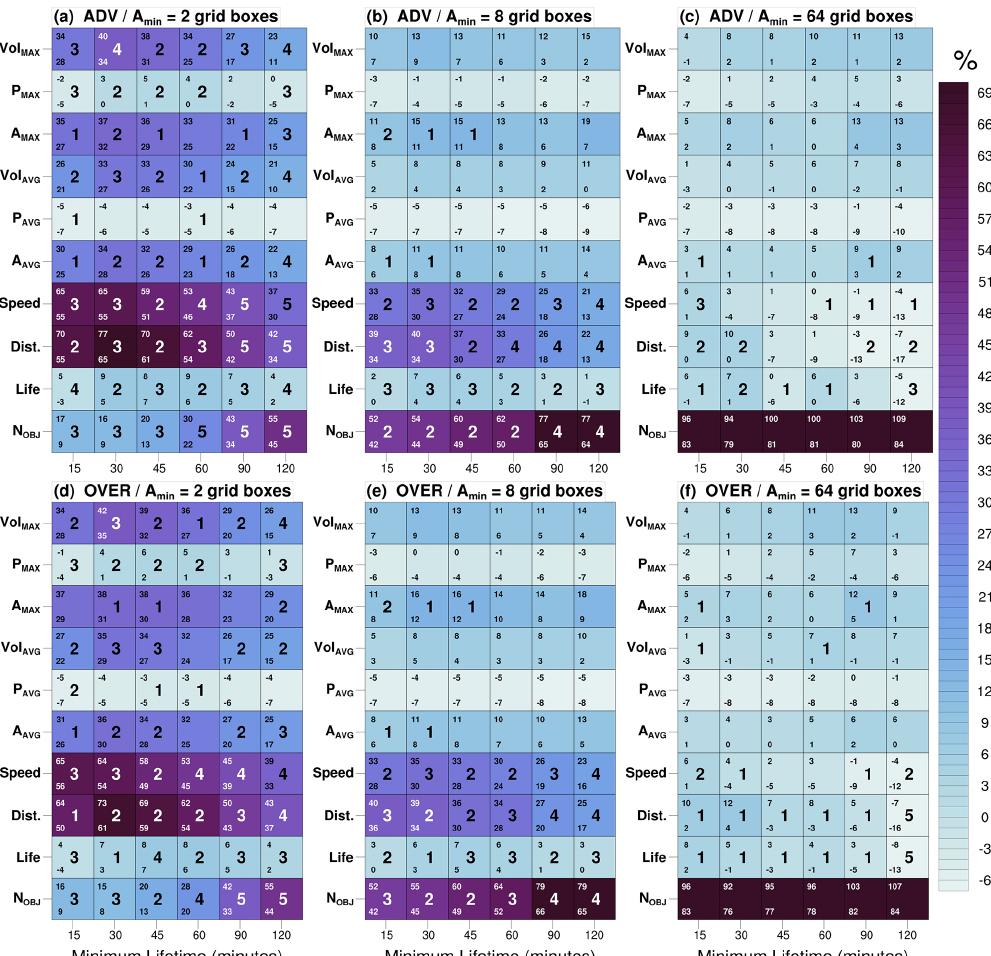
Figure 6. Climate-change signals of all object properties and N obj , as a function of the object’s minimum-lifetime ( T min ) criterion, for both algorithms. A statistically significant difference in the climate-change signal against other T min thresholds is indicated by a number in the box centre. The number denotes how many of the other T min thresholds have a change signal whose difference is statistically significant compared to the box in question (maximum = 5). For example, for the combination (d) OVER, A min = 2, speed and T min = 15min, the number 3 is present: this means that the climate-change signal for this combination has a statistically significant difference to three of the remaining five T min thresholds of OVER, A min = 2 and speed. Confidence intervals, computed as in Sect. 3.4, are given in the left-hand corners of each box. There are no statistically significant differences between the algorithms. The results are shown for three values of A min , with the remaining values of A min found in Fig. S5 and the values underlying the change signal in Fig.